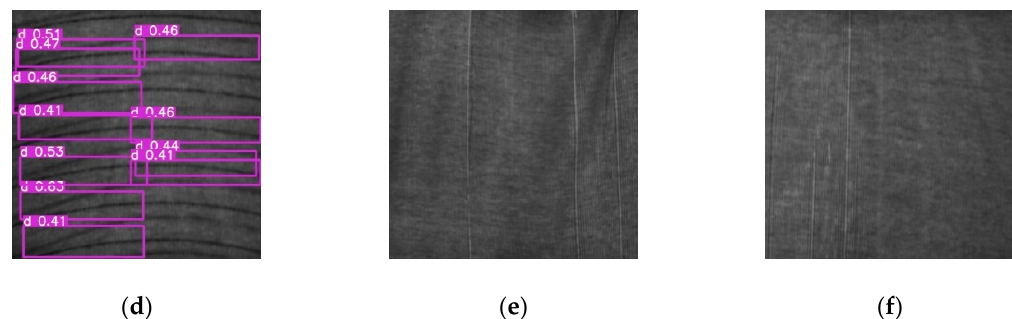
Figure 3. Knitting dataset [10] detection results by implementing the Yolov4 from [12]: ( a ) tearing and broken weft defect; ( b , c ) tearing defect; ( d ) cross piece defect; ( e , f ) broken warp detect.